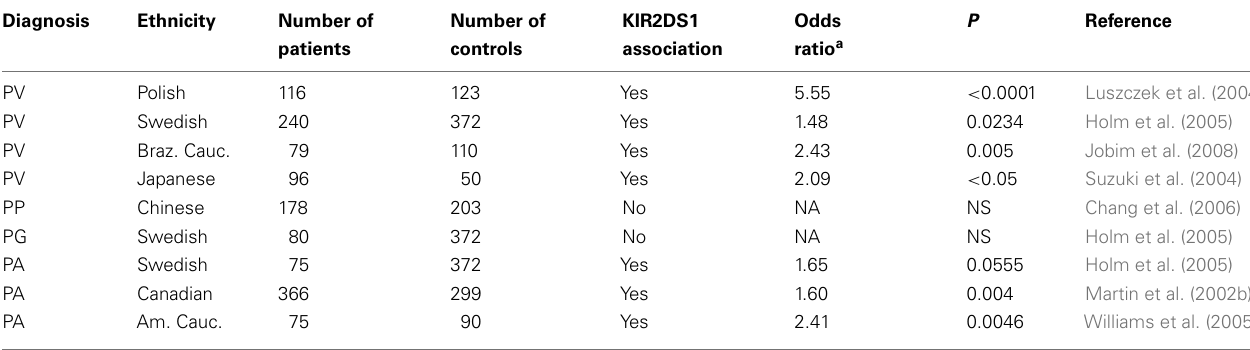
Table 2 | KIR2DS1 gene associations with clinical forms of psoriasis in different ethnic